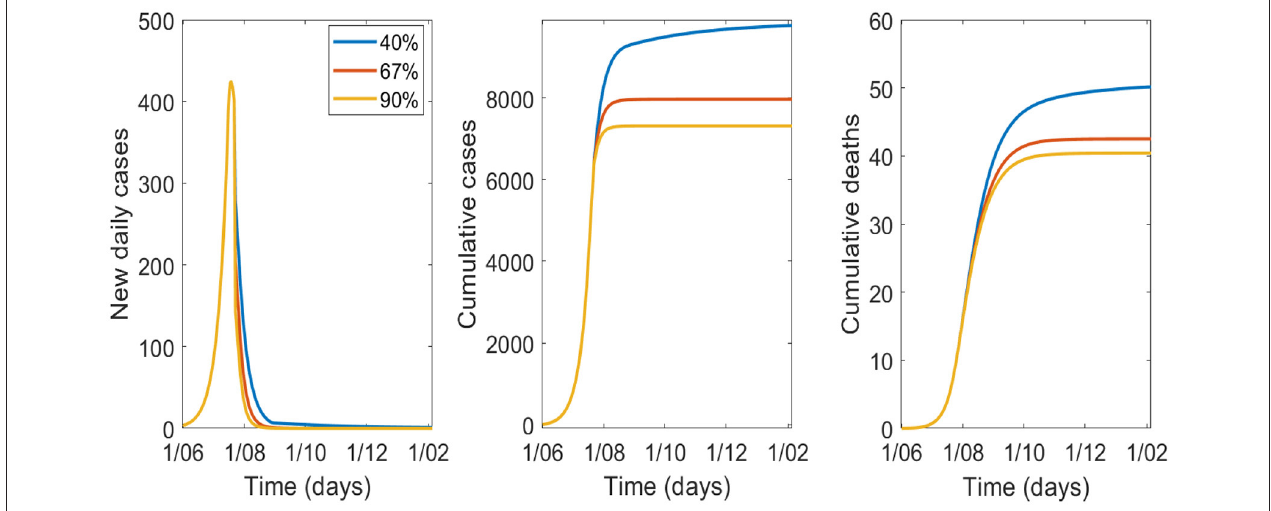
FIGURE 4 | Variation in epidemic control for COVID-19 by varying effectiveness of masks from 40 to 90%, with 70% wearing a mask.